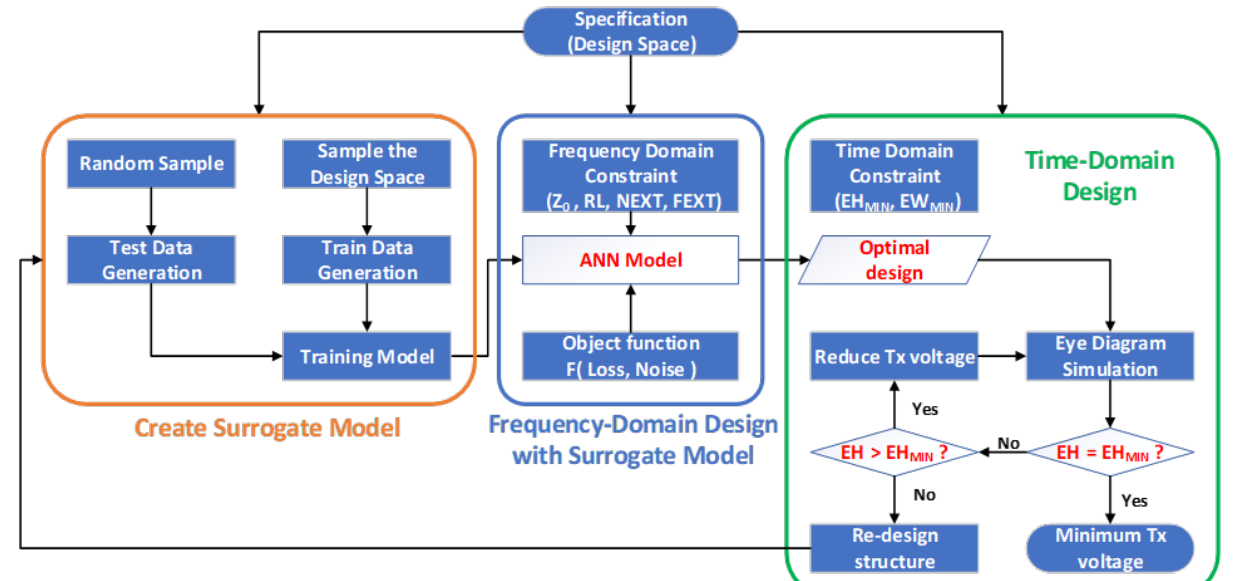
Figure 5. Proposed Design